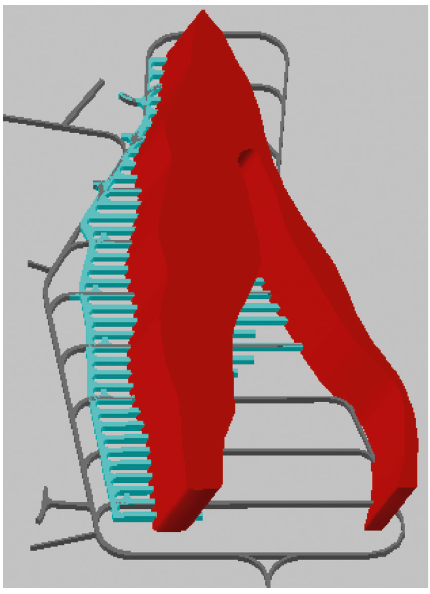
Figure 1: Nonpillar sublevel caving mining in Baoguo Iron